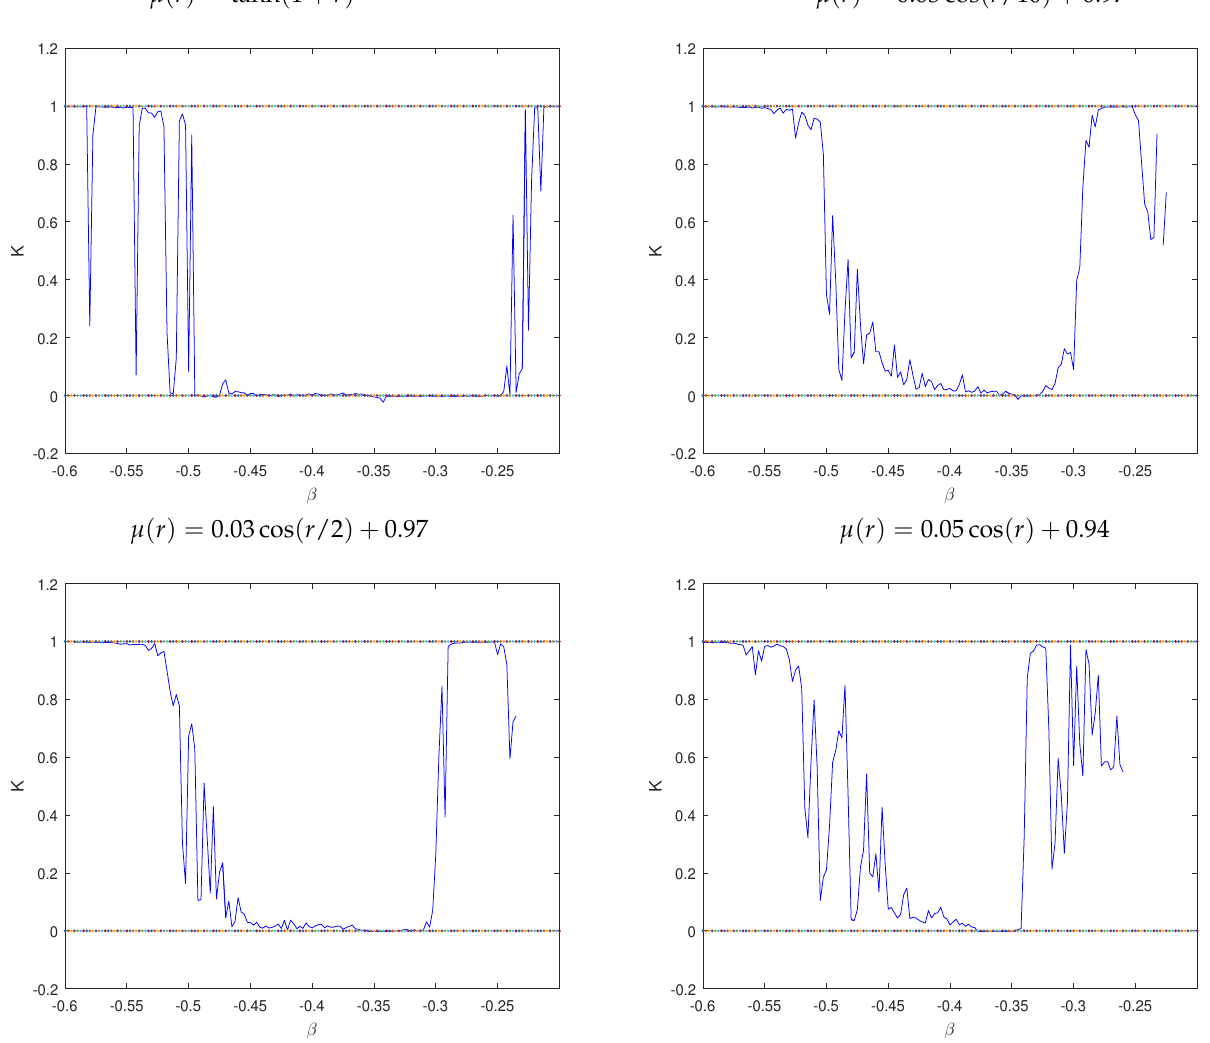
Figure 5. The 0–1 test plots of the Tinkerbell system with the fractional variable-order (8) for different fractional